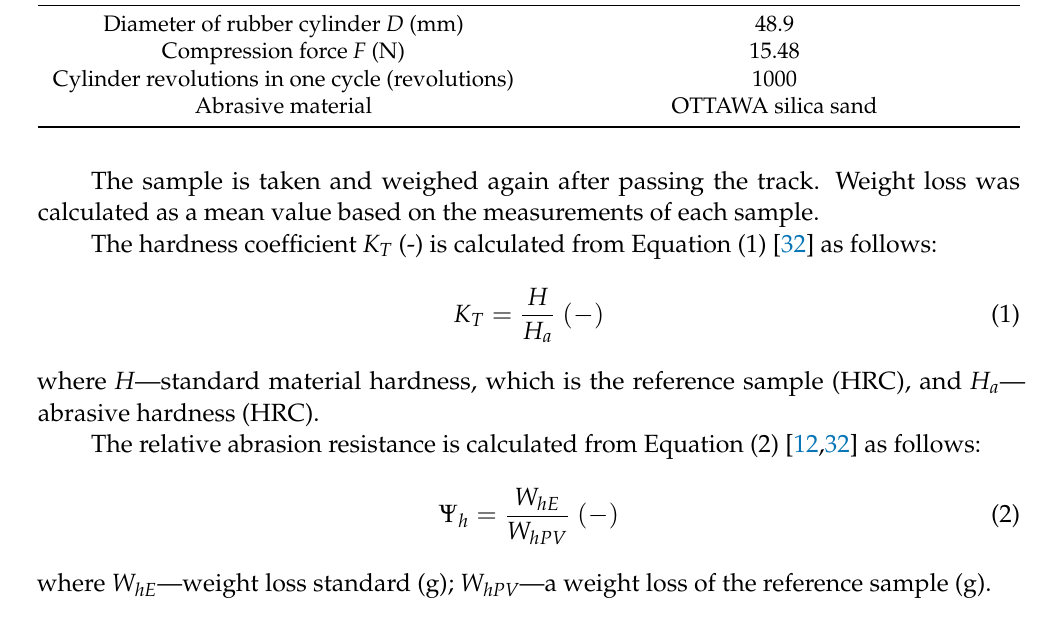
resistance equipment; ( c )—detail of a driving gear with abrasive particles.